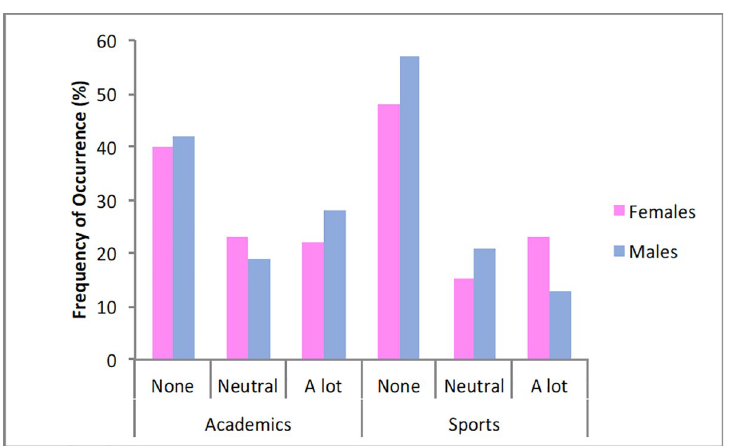
Fig 12. Frequency of occurrence (%) of decreased performances in relation to